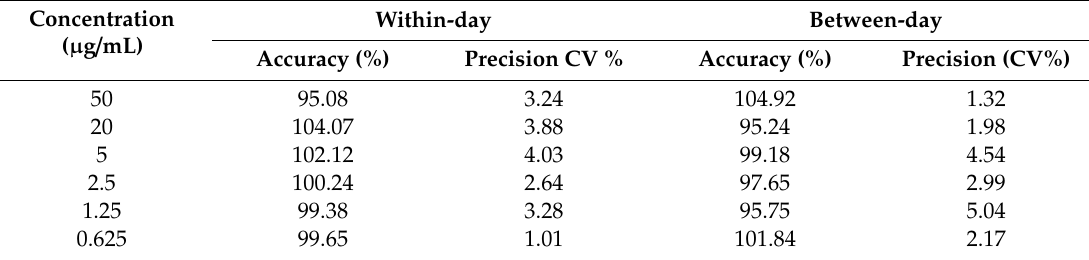
Table 3. Within-day and between-day precision and accuracy values for apigenin.